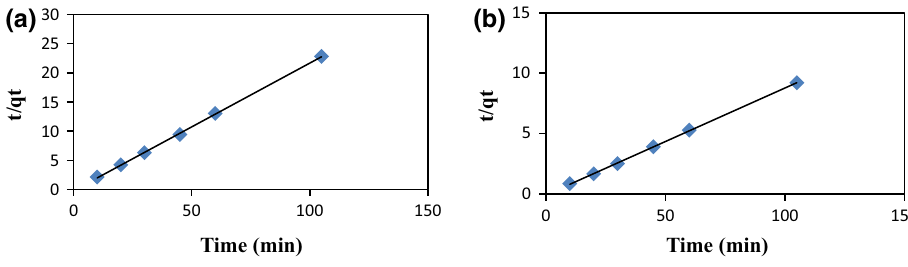
Fig. 6 Pseudo-second-order kinetic plot on a aniline and b phenol removal by bentonite